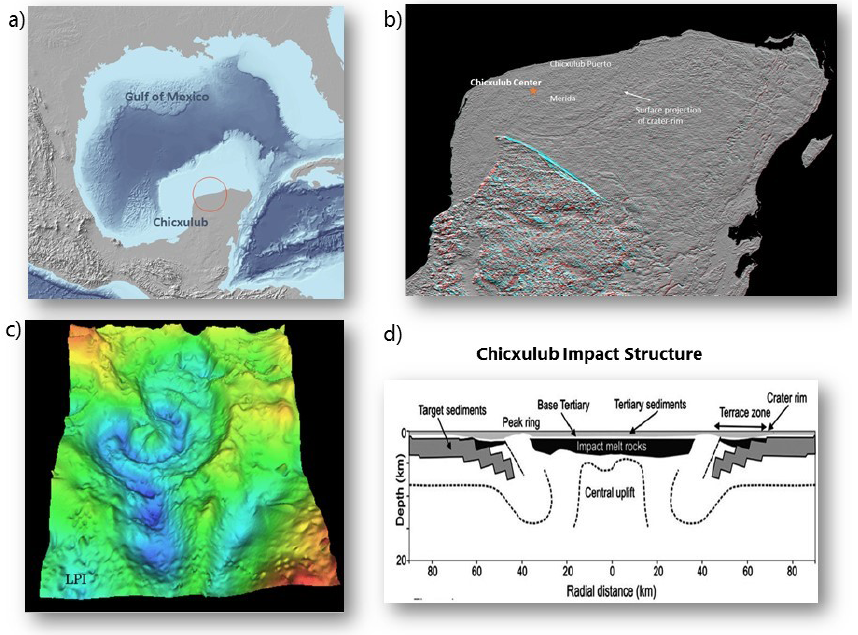
Figure 3. Chicxulub crater. (a) Map of Gulf of Mexico and Yucatán Peninsula, showing location of the Chicxulub crater. (b) Satellite interferometry radar image of the northern Yucatán Peninsula (image courtesy of NASA Jet Propulsion Laboratory), showing the surface topographic semi-circular depression above the buried Chicxulub crater rim. The location of the Chicxulub CIRAS centre is shown by the star and arrow. Also marked for reference is the location of Mérida and Chicxulub Puerto. (c) Chicxulub crater gravity anomaly (Sharpton et al., 1993), showing the concentric semi-circular pattern, with the central gravity high and gravity rings marking the peak-ring and multi- ring morphology. (d) Schematic structural model showing the basin, central uplift, terrace zone, melt sheet, breccias and target Cretaceous sediments (Collins et al., 2008).